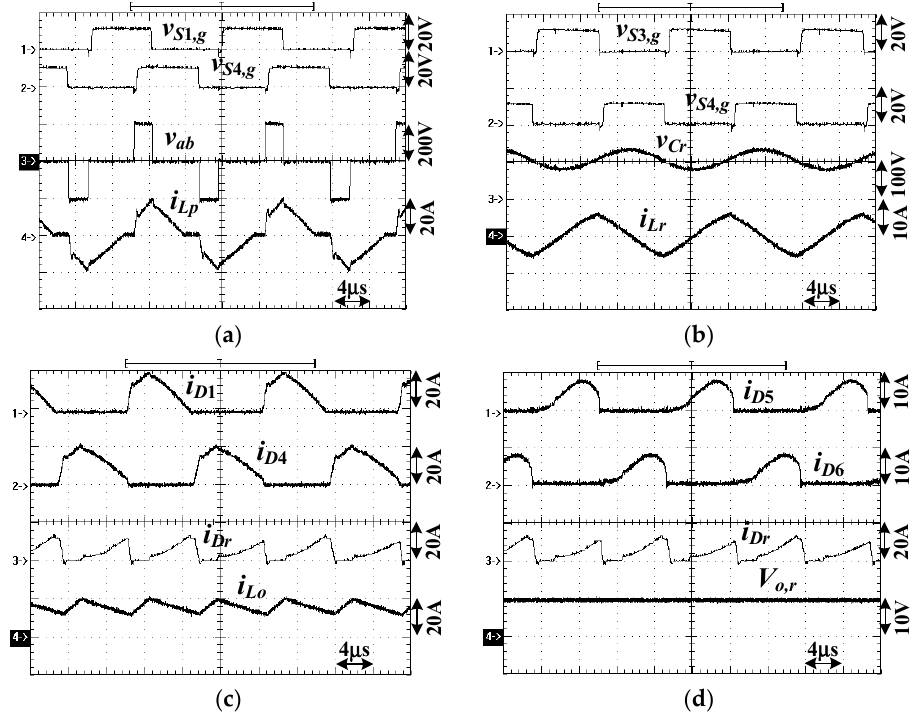
Figure 7. Measured results at V in = 210 V and full load under low voltage input region ( a ) v S 1 ,g , v S 4 ,g , v ab , and i Lp ( b ) v S 3 ,g , v S 4 ,g , v Cr , and i Lr ( c ) i D 1 , i D 4 , i Dr , and i Lo ( d ) i D 5 , i D 6 , i Dr , and V o,r .